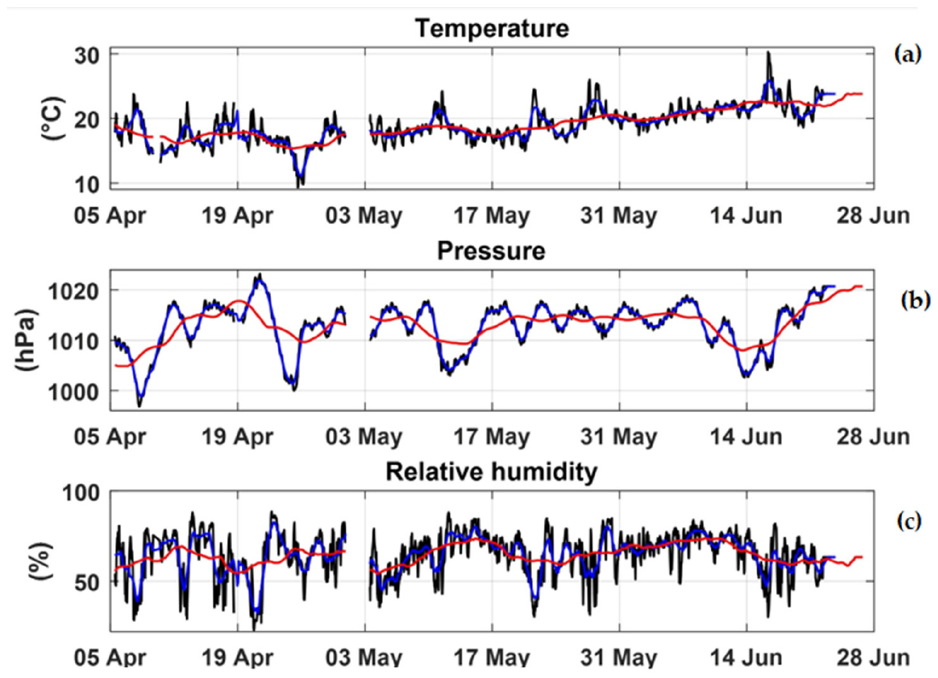
Figure 3. Time series of air temperature T a ( a ), sea level pressure P a ( b ) and relative humidity R h ( c ) measured by the MEDA B Napoli buoy in April–June 2016 (black line), along with their daily (blue line) and weekly average (red line).